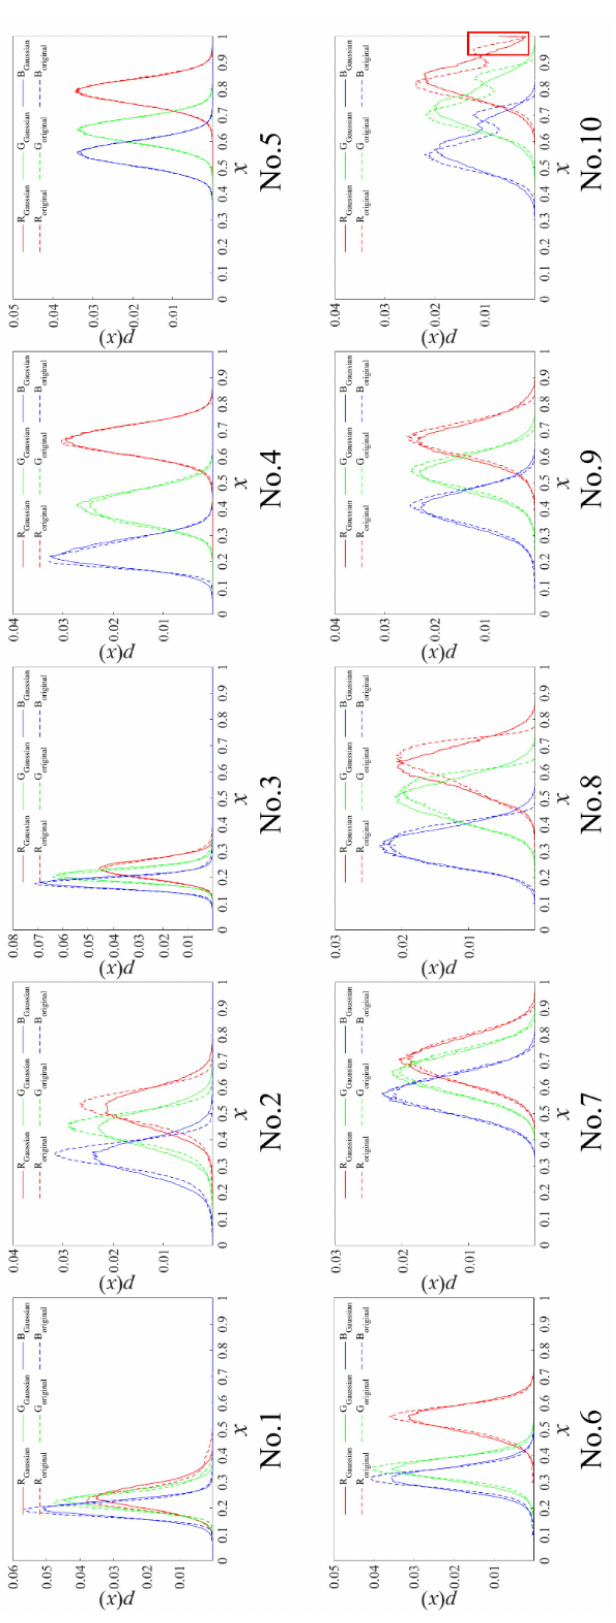
Figure 2. RGB histograms of the ten images before and after the Gaussian histogram